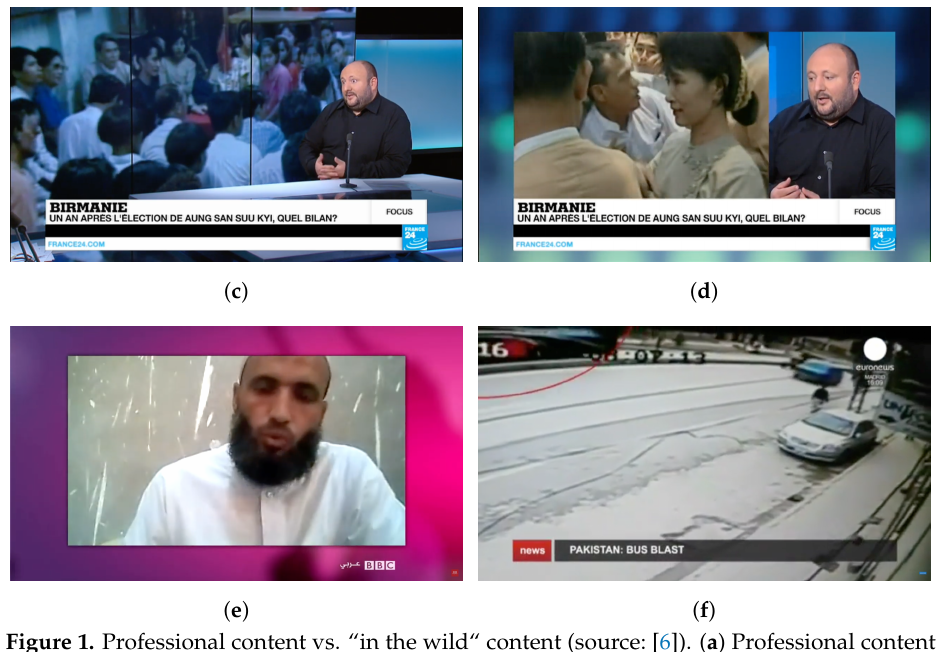
Figure 1. Professional content vs. “in the wild“ content (source: [6]). ( a ) Professional content with no “in the wild” content; ( b ) Professional content with “in the wild” content displayed in small area; ( c ) Professional content with “in the wild” content displayed in large area; ( d ) “in the wild” content with professional content mixed in large area; ( e ) “in the wild” content with professional content mixed in small area; ( f ) “in the wild” content with no professional